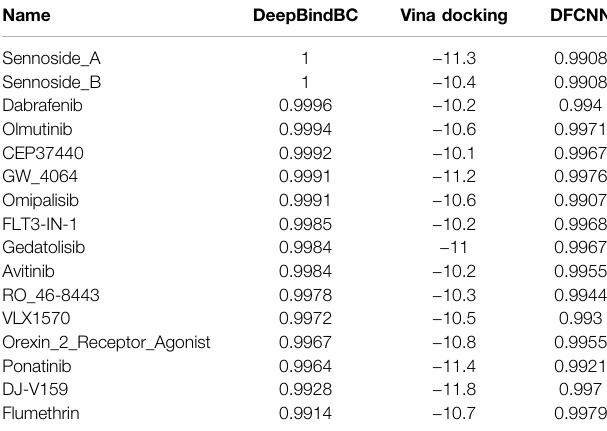
TABLE 1 | The potential inhibitors of TIPE2 from the three TargetMol datasets (DeepBindBC > 0.99, Vina Docking < (cid:1) − 10, and DFCNN > 0.99). The table was ranked by DeepBindBC score in descending order.